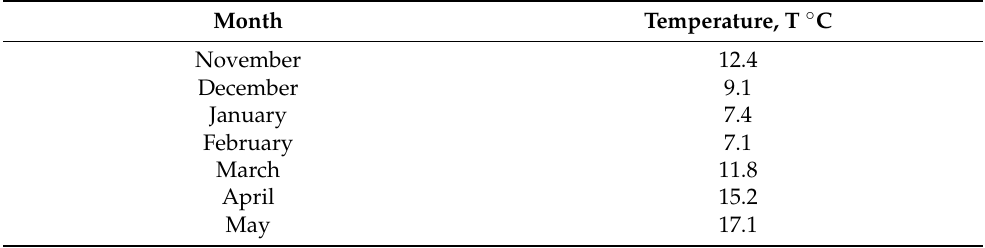
Table 1. Average water temperature values (T ◦ C) detected in the RTW 1 group.